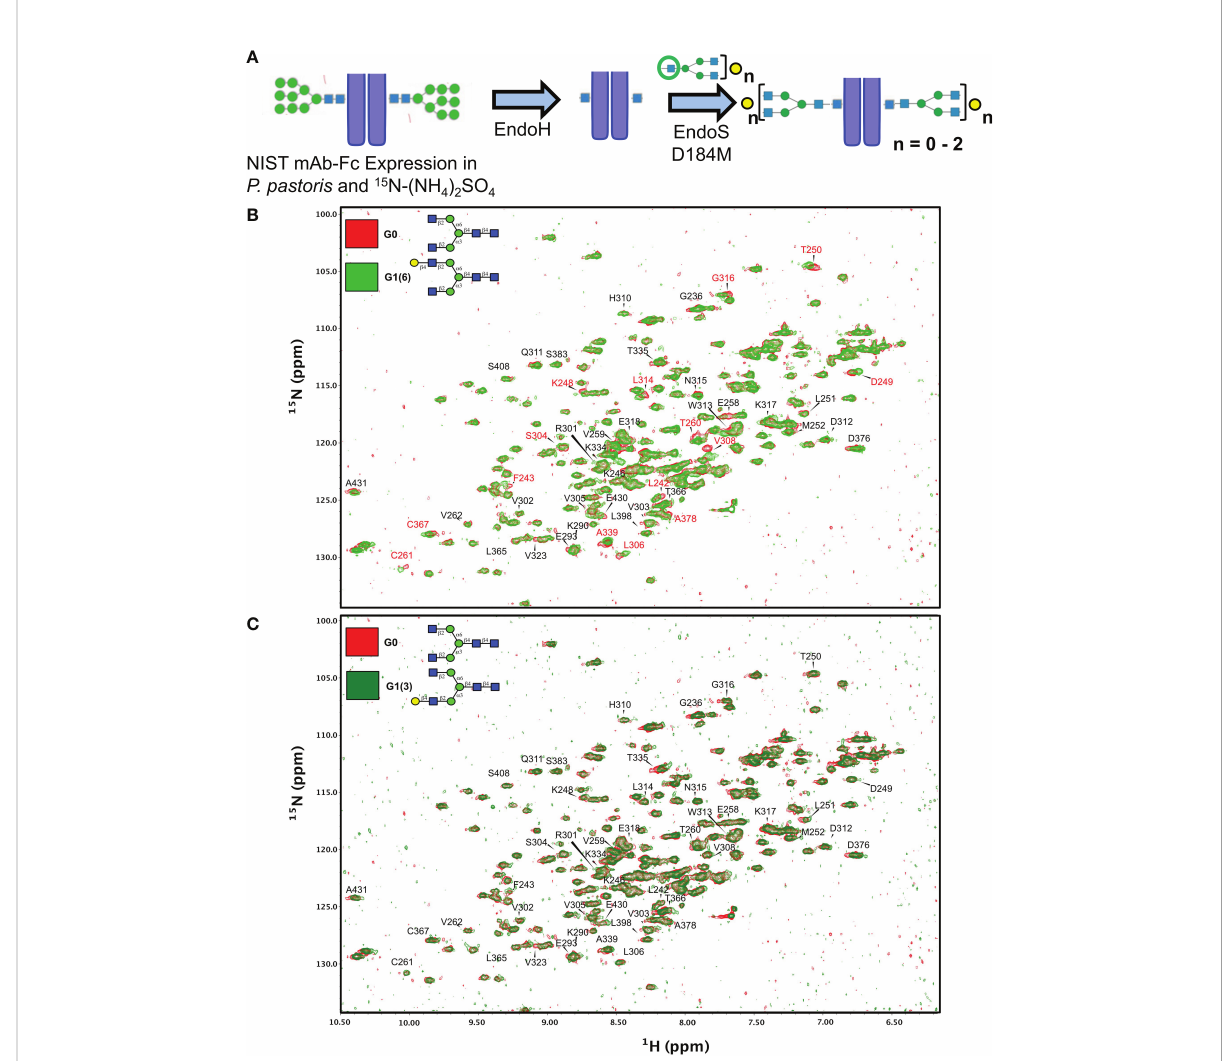
FIGURE 5 Synthetic scheme and NMR characterization of 15 N-isotopically labelled Fc subunits with homogenous monogalactosylated glycoforms. (A) Synthetic scheme showing the remodeling of 15 N-labelled Fc proteins expressed in P. pastoris and remodelled with sequential treatment with EndoH and EndoS D184M and puri fi ed glycan oxazolines. (B, C) Overlay of 2D- 1 H- 15 N NMR spectra of agalactosylated 15 N-G0-NISTmAb-Fc (red) with (B) 15 N-G1(6)-NISTmAb-Fc (bright green) and (C) 15 N-G1(3)-NISTmAb-Fc (dark green). Peptide backbone amino acid residues are labelled, and Combined Chemical Shift Differences (CCSDs) are calculated for those labeled in red and are shown in Table